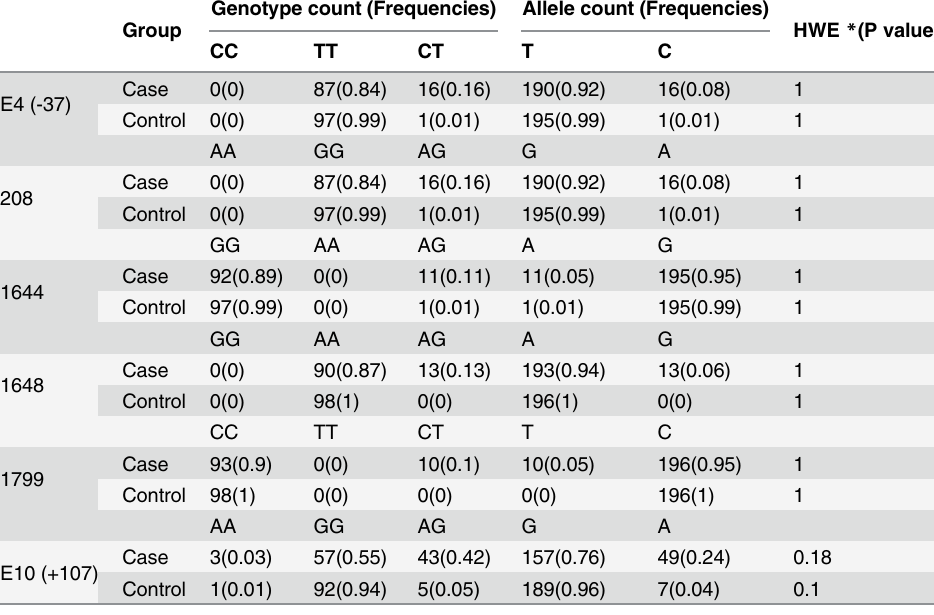
Table 2. Genotype and allele distribution of CARD15 gene polymorphisms (SNP) in cases and controls. Genotype count Group